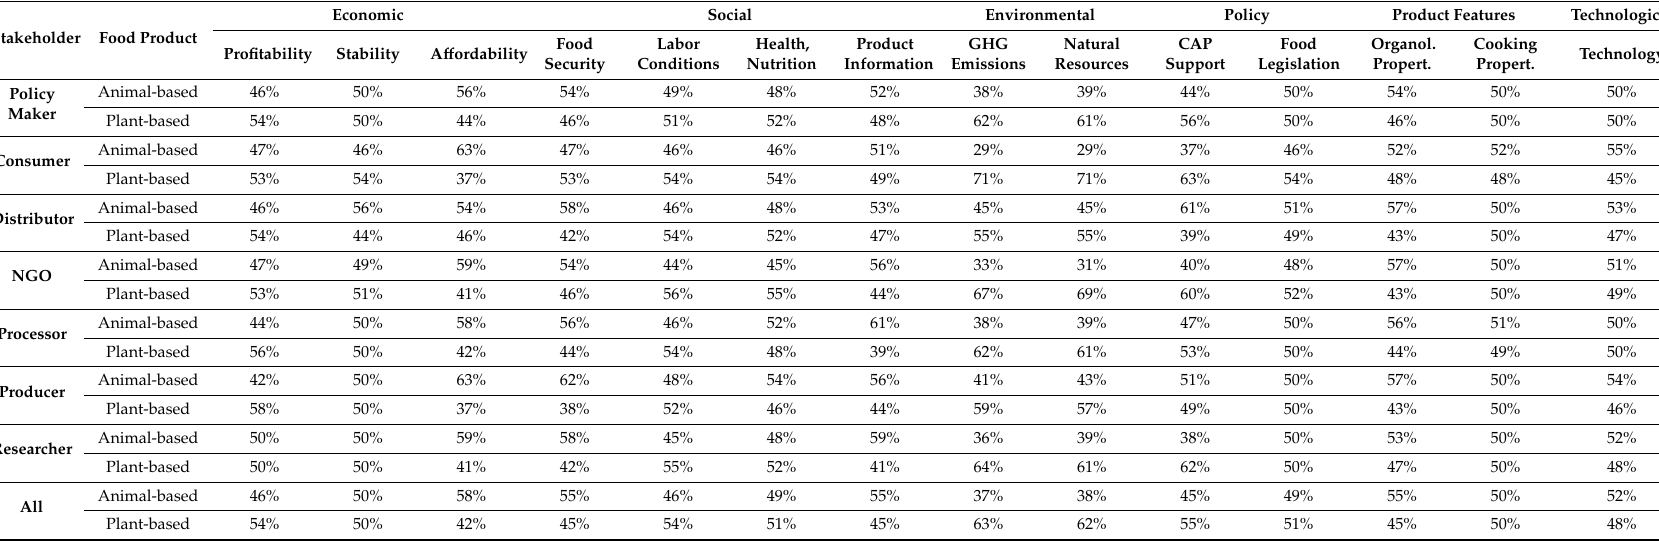
Table A3. Performance of animal-based and plant-based products under each sub-criterion by stakeholder group (average weight of each sub-criterion in percentage). Economic Social Environmental Policy Product Features Technological Stakeholder Food Product Profitability Stability Product Information